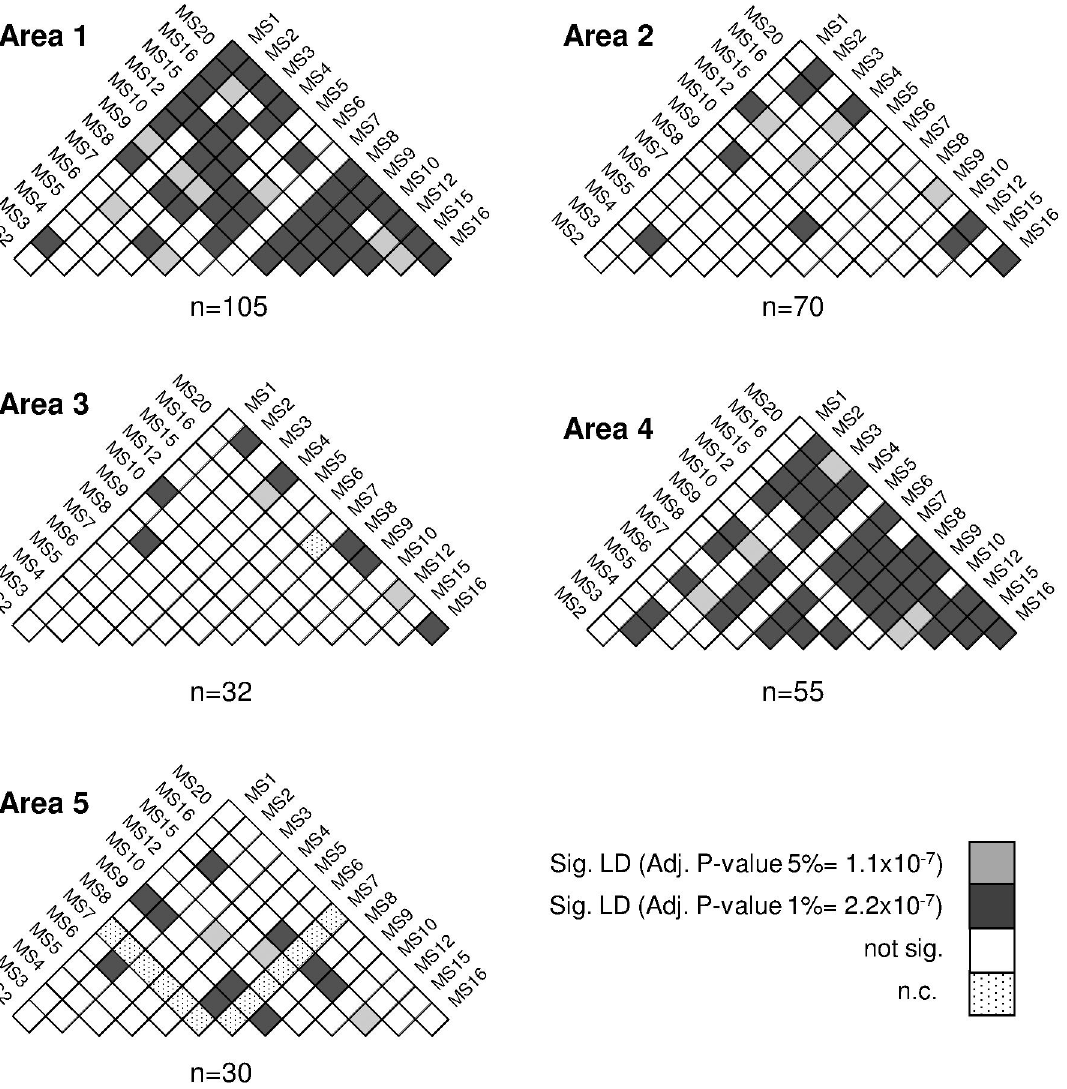
Fig 4. Pairwise-locus linkage disequilibrium analysis by study areas. Significant association between alleles at pairs of loci in each isolate (LD) was tested using FSTAT. p -Values were adjusted after Bonferroni corrections and depicted by a colour as described in the legend. Isolates with missing alleles where included in the